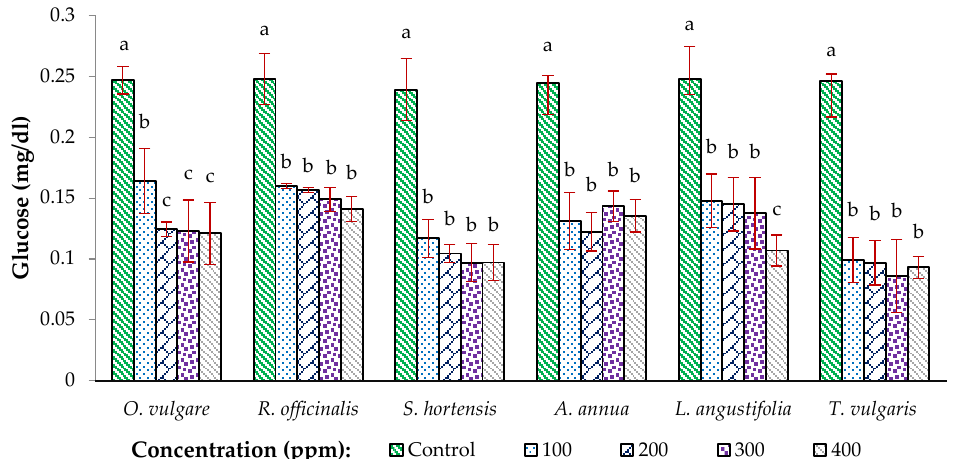
Figure 3. Effect of different concentrations of essential oils on total glucose (mg/dL) of Xanthogaleruca luteola eggs. Statistical differences are shown by different letters according to Tukey’s test at p ≤ 0.05.